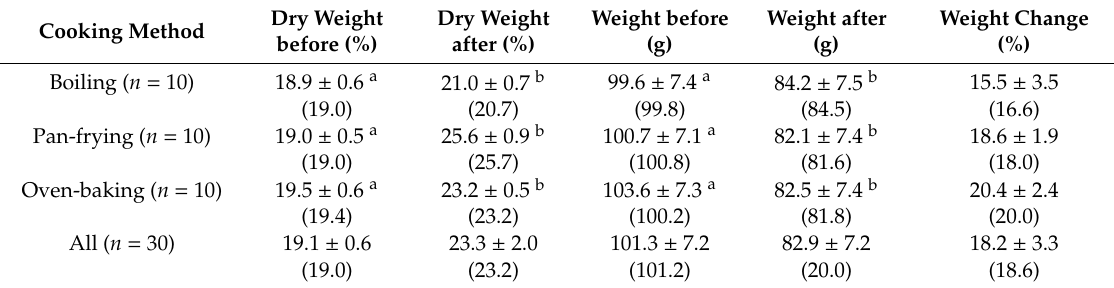
Table 2. Dry weight (%) and weight (g) of the cod fillets before and after the di ff erent cooking methods and percent change of weight in wet weight. Numbers are given as mean ± SD and